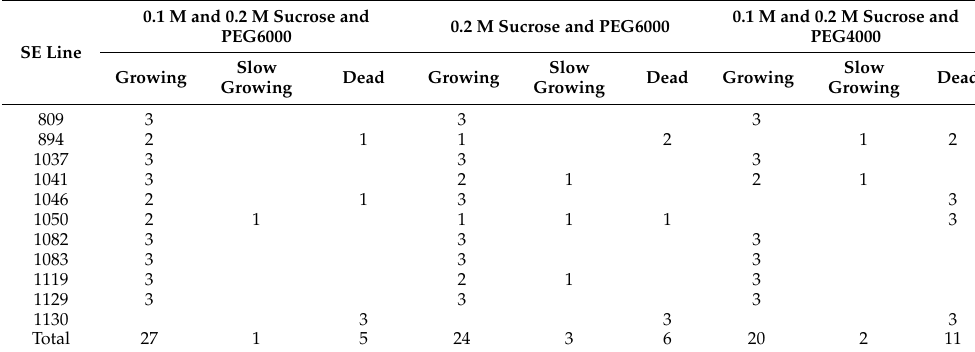
lower, i.e., 44.76 ± 10.51, but the difference was not significant. Before the cryopreservation experiments, the embryo capacity of the same seven lines was 112.14 ± 59.48 E/g FW. Table 4. Number of samples regenerated after different pre-treatments and cryopreservation in Experiment III. The pre-treatments were 24 h in both 0.2 M and 0.1 M sugar concentration mLM media or 24 h in 0.2 M sucrose concentration mLM medium. The two-step sucrose treatment with PEG4000 instead of PEG6000 in a cryoprotectant solution (composed of PEG, glucose, and Me 2 SO) was also tested. In thawing, the samples were first placed on 0.1 M sucrose media for 24 h before proliferation media (0.03 M sucrose concentration). Three cryovials containing ET from the same genotype from every experimental medium were stored in LN.